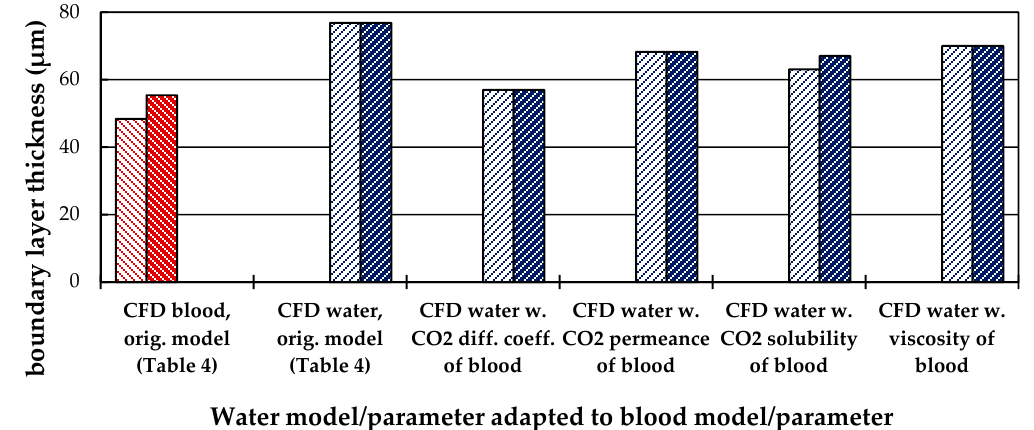
Figure 20. Influence of CO 2 diffusion, CO 2 permeance, CO 2 solubility, and viscosity model on the boundary layer thickness.